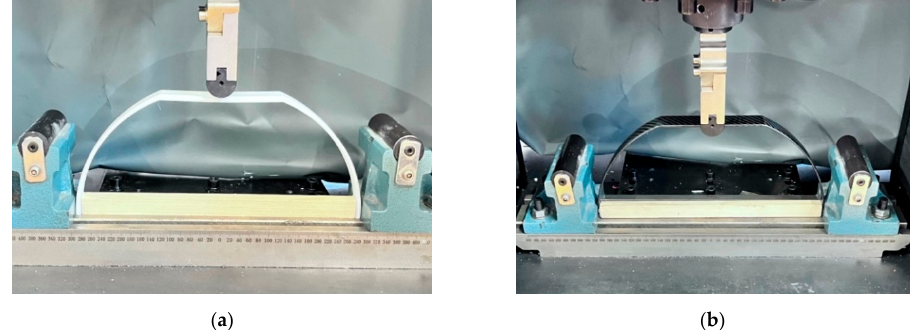
Figure 3. Three-point bending test for the landing gears made of: ( a ) PLA GF; ( b ) CFRP.